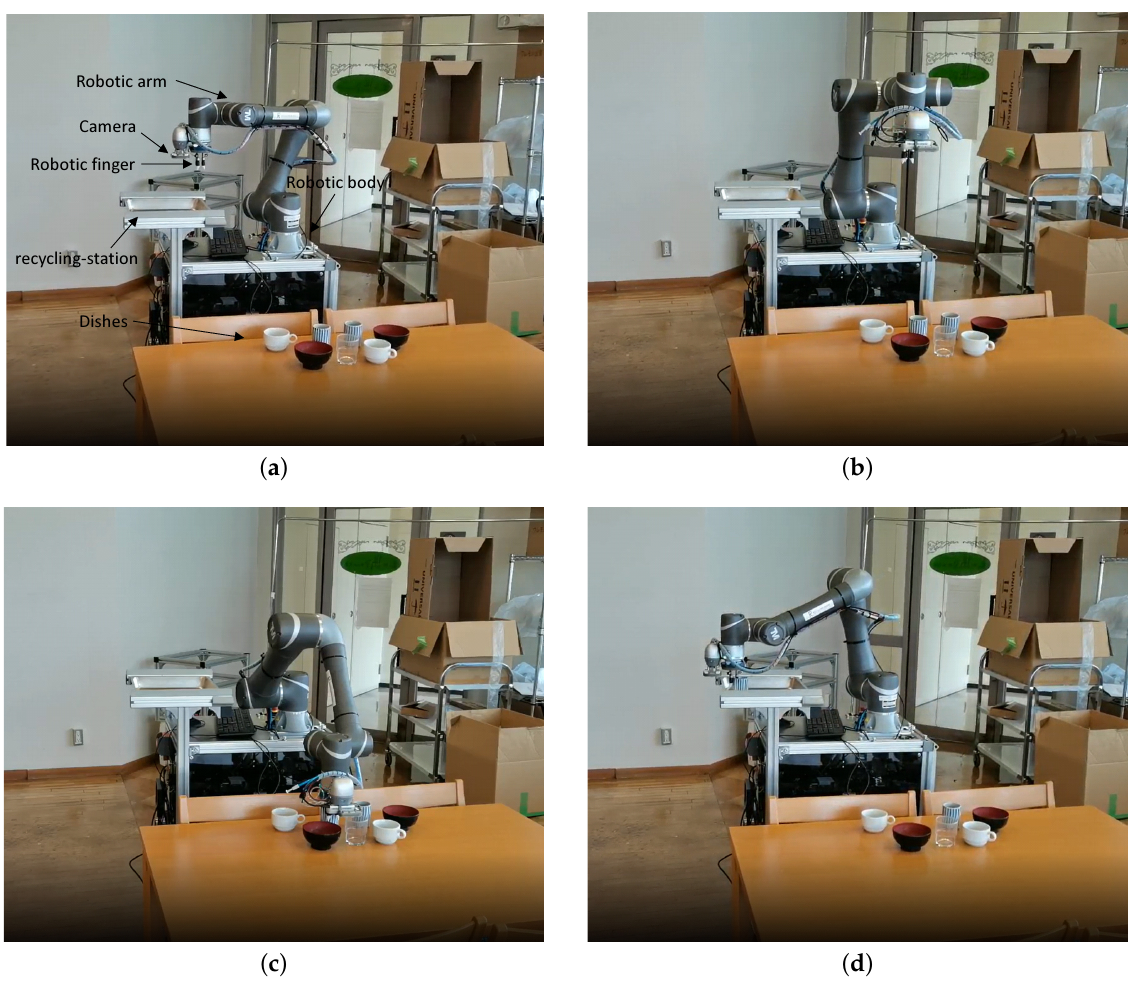
Figure 1. Overview of empty-dish recycling robot. ( a ) Initial state, ( b ) detecting state, ( c ) catching state, and ( d ) recycling